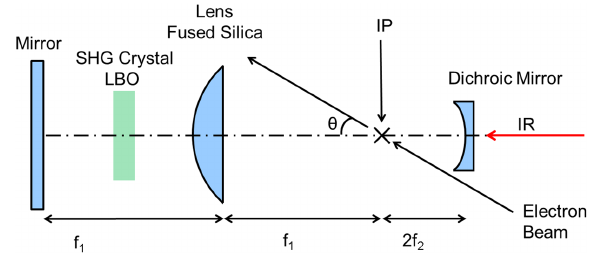
FIG. 17. Schematic of the linear ringdown cavity with the interaction point labeled IP corresponding to both the electron beam and laser beam waist. The electron beam is at an angle θ ¼ 50 mrad with respect to the laser beam.